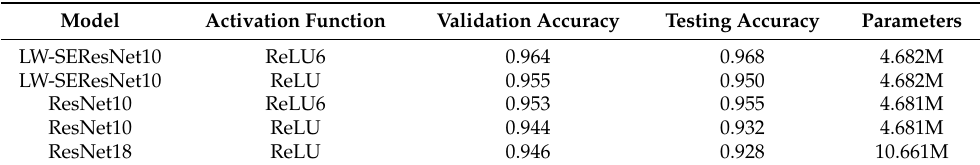
Table 3. The experiment results on model accuracy and parameters.